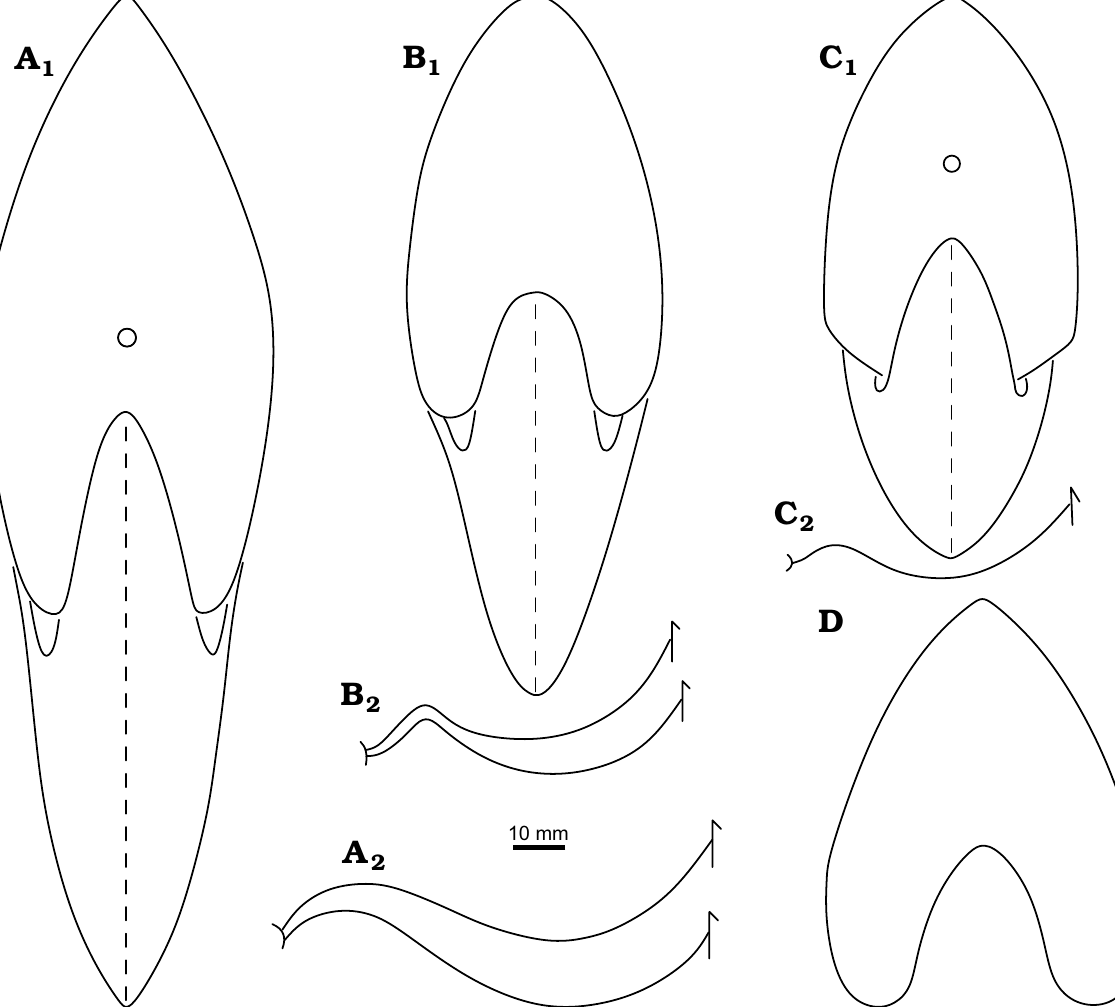
Fig. 6. Shell form (A 1 –C 1 ), external sutures (A 2 –C 2 ), and whorl cross-section (D) of selected hercoglossid nautiloids. A . Nautilus mermeti (Coquand, 1862) from the Cenomanian of Ténoukla near Tébassa, northeast Algeria (after Coquand 1862: pl. 2: 1, 2). B . Nautilus munieri Choffat, 1886 from the upper Cenomanian of Villa Nova d’Ourem, Portugal (after Choffat 1886: pl. 2: 1). C . Angulithes triangularis Montfort, 1808 (MB.C.2052) from the lower Sardinero Formation, lower Middle Cenomanian of Langre, Cantabria, northern Spain (after Wilmsen 2000: pl. 1: 2b, pl. 5: 15). D . Nautilus triangularis Montfort, 1808 from the Cenomanian of Île de Madame, Charente-Maritime, France (after d’Orbigny 1840: pl. 12: